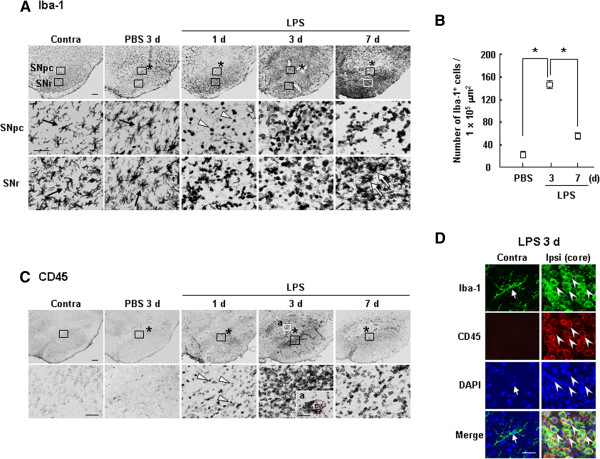
Appearance of Iba-1+/CD45+ round cells in the LPS-injected SNpc. (A, C, D) Serial sections were obtained at the indicated times after LPS injection and labeled with Iba-1 (A), CD45 (C), and Iba-1/CD45 (D) antibodies. (A, C) Lower panels are higher magnification images of the boxed areas in the upper panels. (A) In intact contralateral (Contra) sides and PBS-injected brains, Iba-1+ cells were ramified (black arrows). In LPS-injected brain, round Iba-1+ cells were detectable at 1 d (white arrowheads), and the number of these cells increased at 3 d but decreased at 7 d. In SNr areas, Iba-1+ cells became ramified and highly expressed Iba-1 at 7 d (white arrows). (B) Iba-1+ cells at the indicated times after LPS injection were quantified. Values are means ± SEMs of more than three samples (*p < 0.001; Student’s t-test). (C) CD45+ cells were detectable at 1 d (white arrowheads), and the number of these cells increased at 3 d but decreased at 7 d. Some round CD45+ cells were found around blood vessels (BV) (inset ‘a’ in 3 d). (D) Brain sections obtained at 3 d were double-labeled with Iba-1 and CD45 antibodies, and visualized with Alexa Fluor 488- and 555-conjugated antibodies, respectively. Asterisks (*) indicate drug injection sites. Scale bars, 200 μm (upper panels in A, C), 50 μm (lower panels and the inset in A, C), and 20 μm (D).